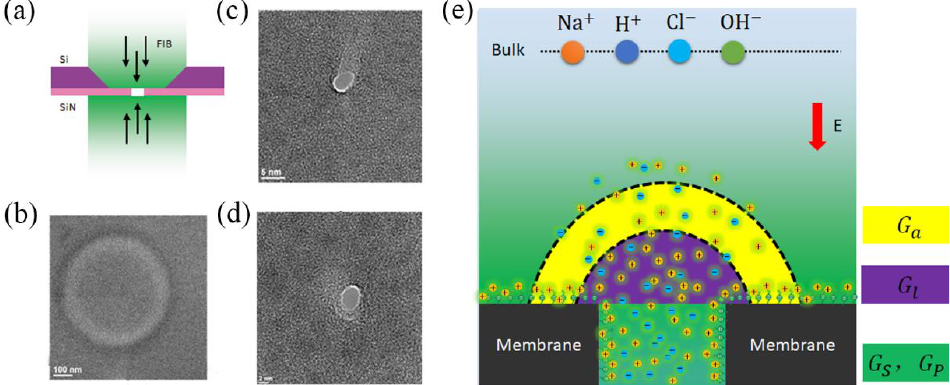
Figure 1. The setup of measuring the ionic currents through nanopores. ( a ) Nanopore fabrication scheme. ( b ) A TEM image of thinned area of silicon nitride film. ( c ) A TEM image of a 3.6 nm nanopore. ( d ) A TEM image of a 2 nm nanopore. ( e ) Schematic illustration of ion migration in a digital nanopore. The salt solution contains four ions, OH − /Cl − /H + /Na + . The voltage drives